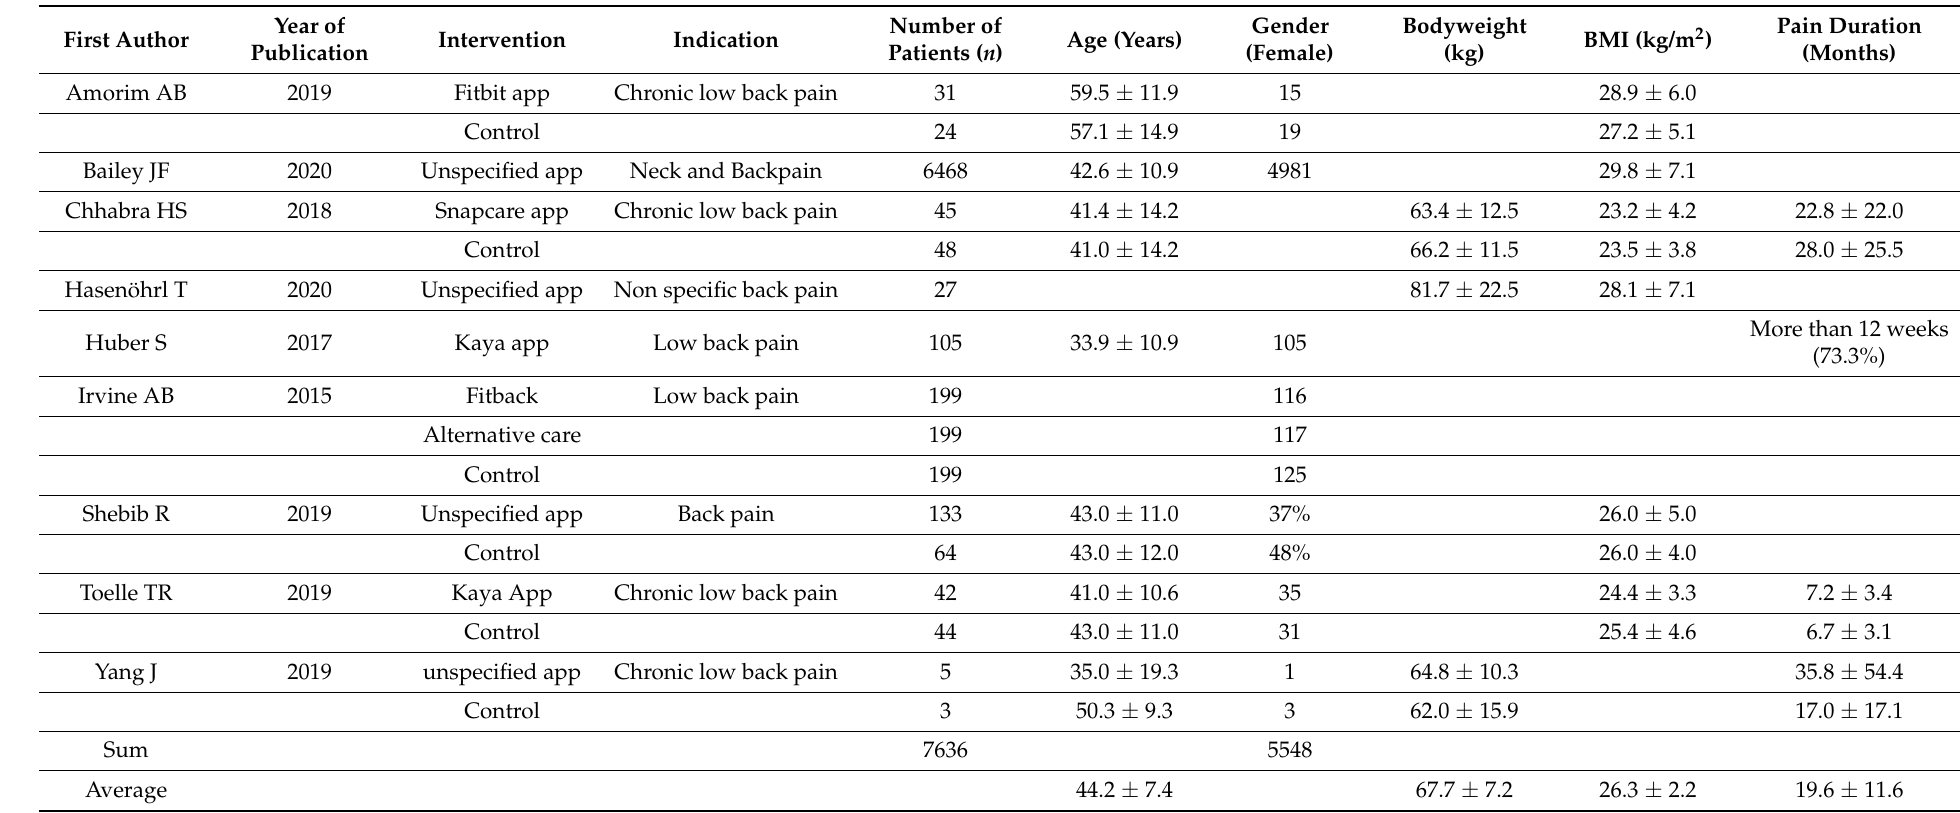
Table 2. Demographics of all included